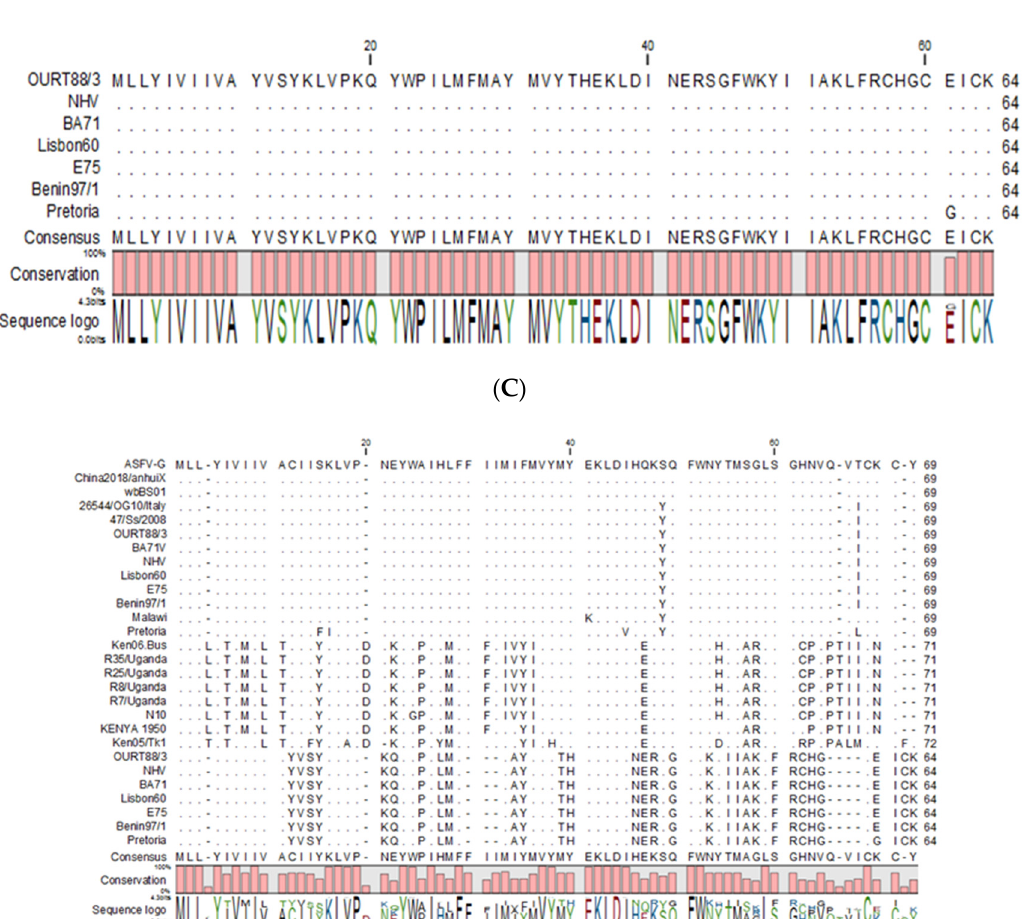
Figure 1. Multiple sequence alignment of the indicated African swine fever virus (ASFV) isolates for proteins. ( A ) X69R, ( B ) J64R, or ( C ) both X69R and J64R genes. Matching residues are represented as dots. The degree of conservation is presented below the protein sequence, and the conserved residue is presented on the bottom, indicating the degree of conservation for particular amino acids in the protein sequence.